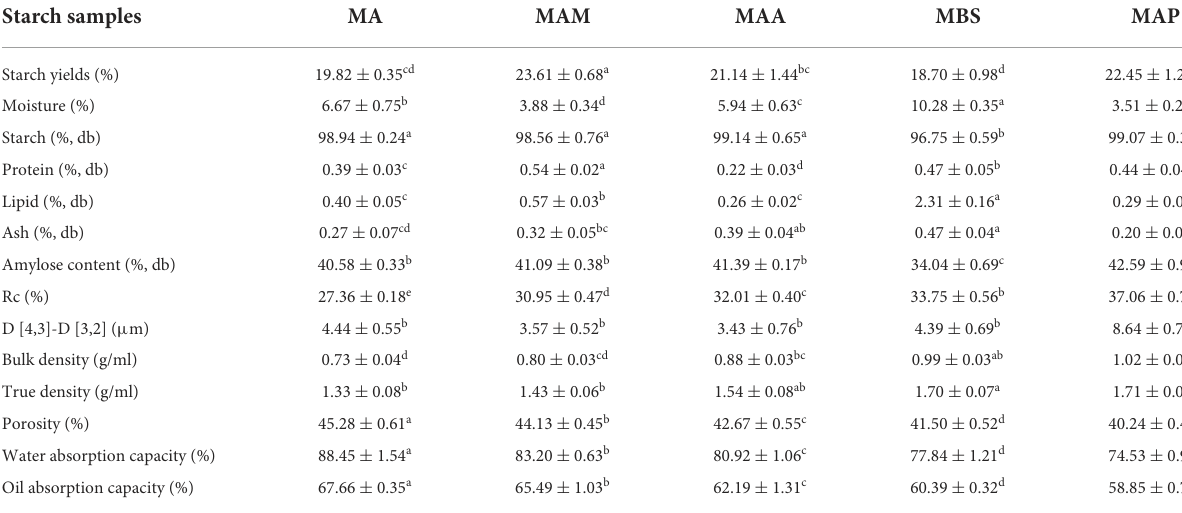
TABLE 1 Chemical composition, granule size and distribution, bulk, true density, porosity, and water and oil absorption capacity of starch samples isolated from five different banana species. Starch